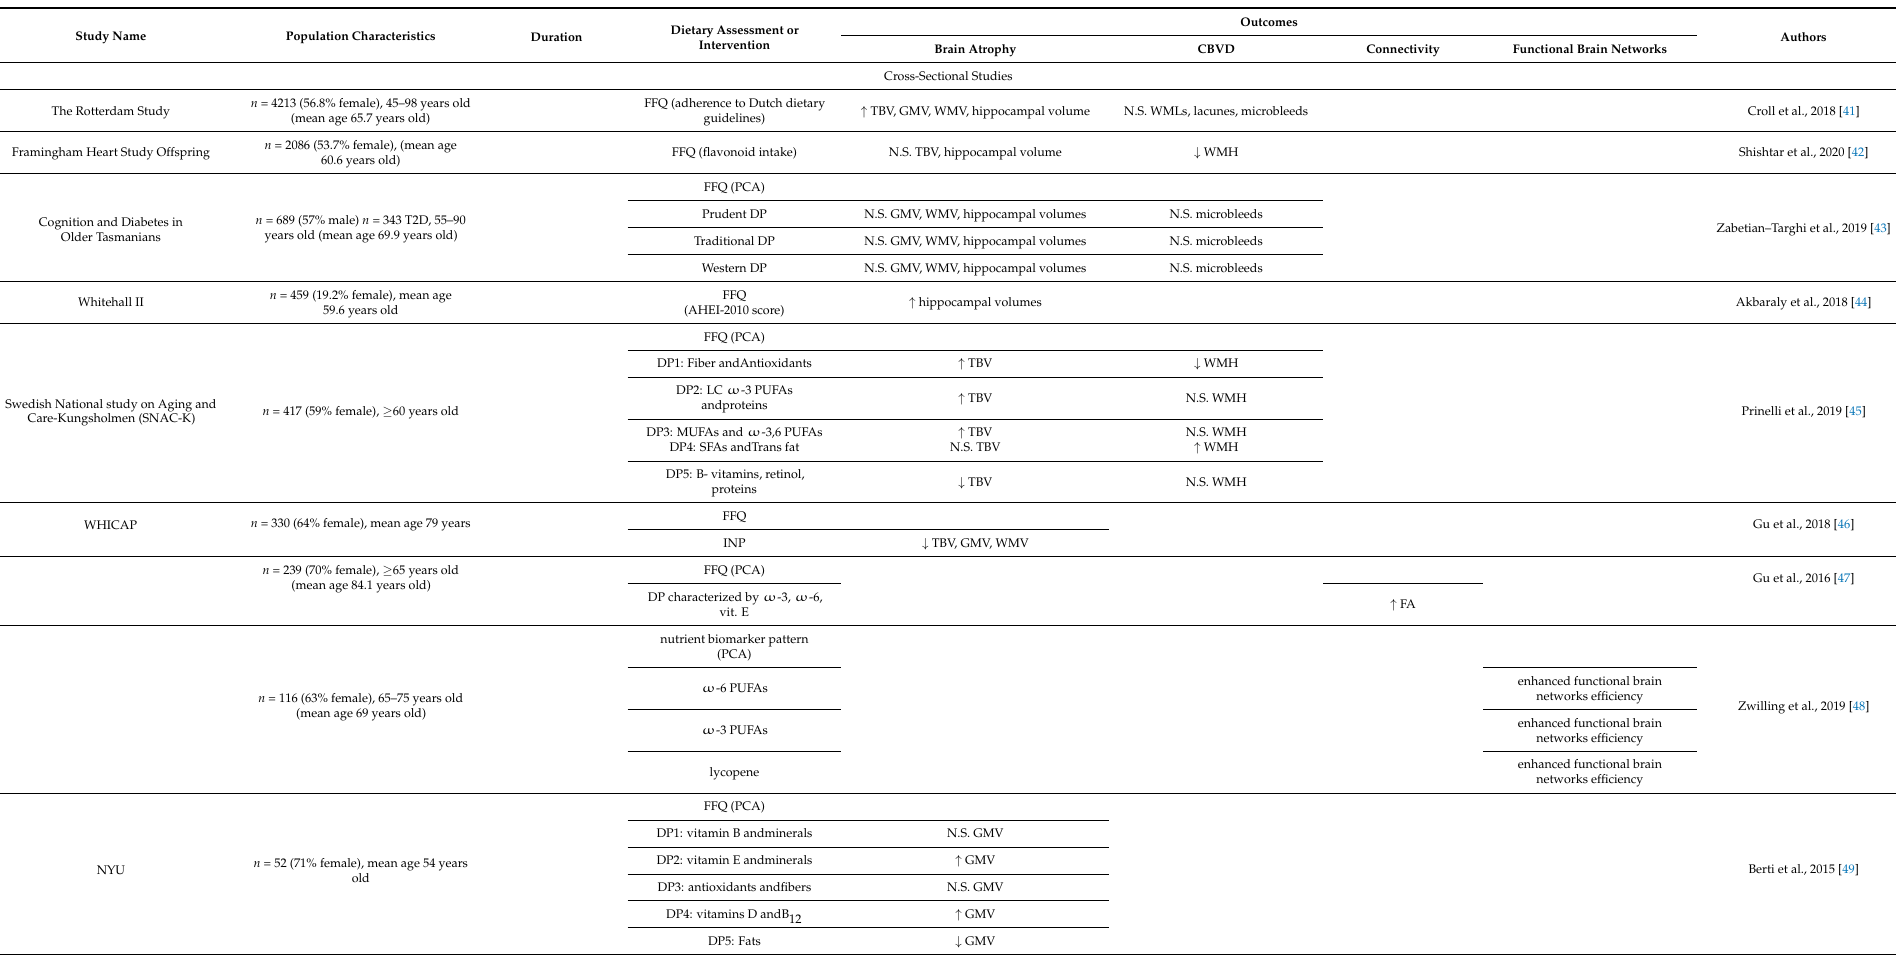
Table 2. Studies examining the association between dietary or nutrient patterns other than the Mediterranean diet and brain MRI biomarkers in adults without